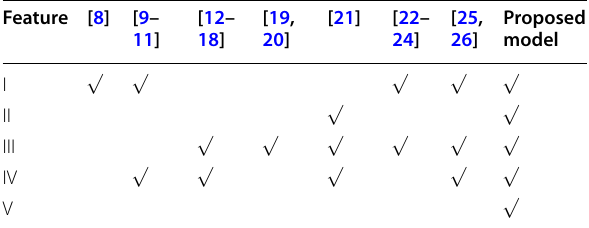
I: Fault indicator is considered for installation. II: I-type switch is considered for installation. III: V-type switch is considered for installation. IV: The global optimal solution can be obtained. V: Considering functional failure probability